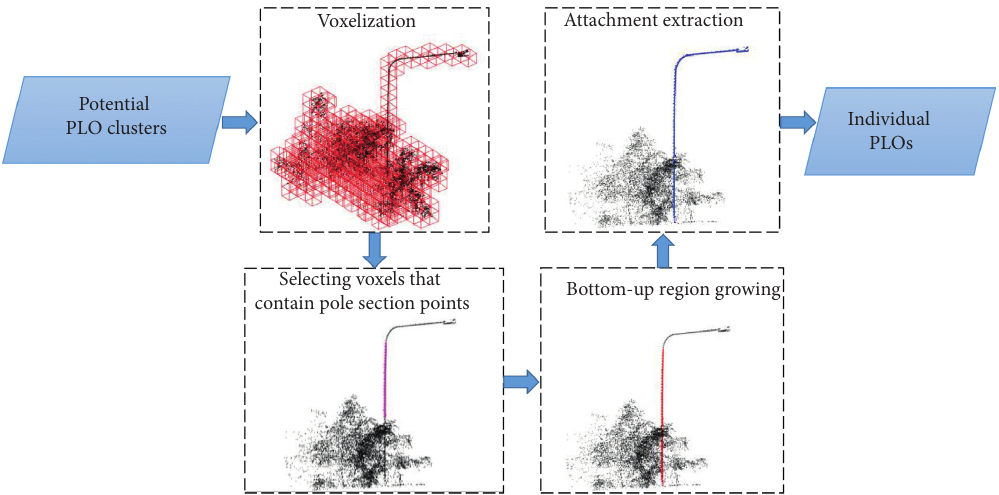
Figure 5: Workflow for PLO detection from mixed clusters.